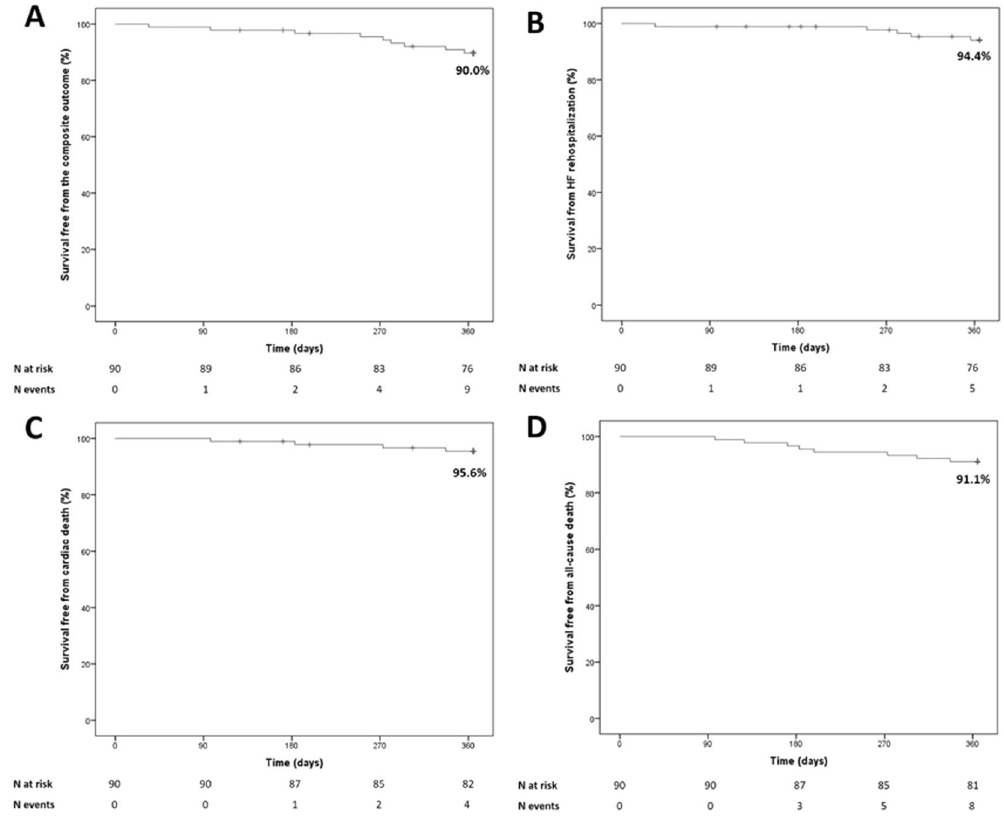
Figure 1. Survival free from worsening HF (panel A), composite outcome (panel B), cardiac death (panel C) and all-cause death (panel D) in the study population. HF, heart